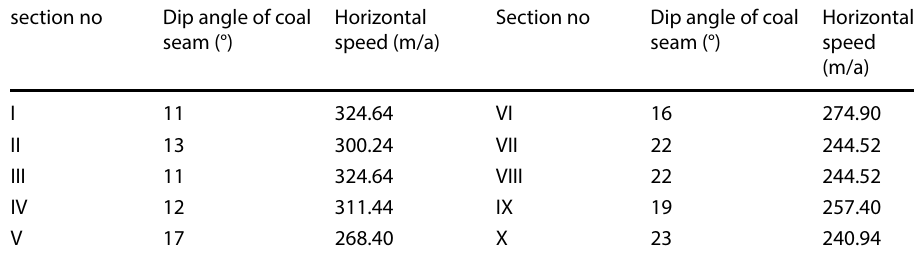
section no Dip angle of coal seam